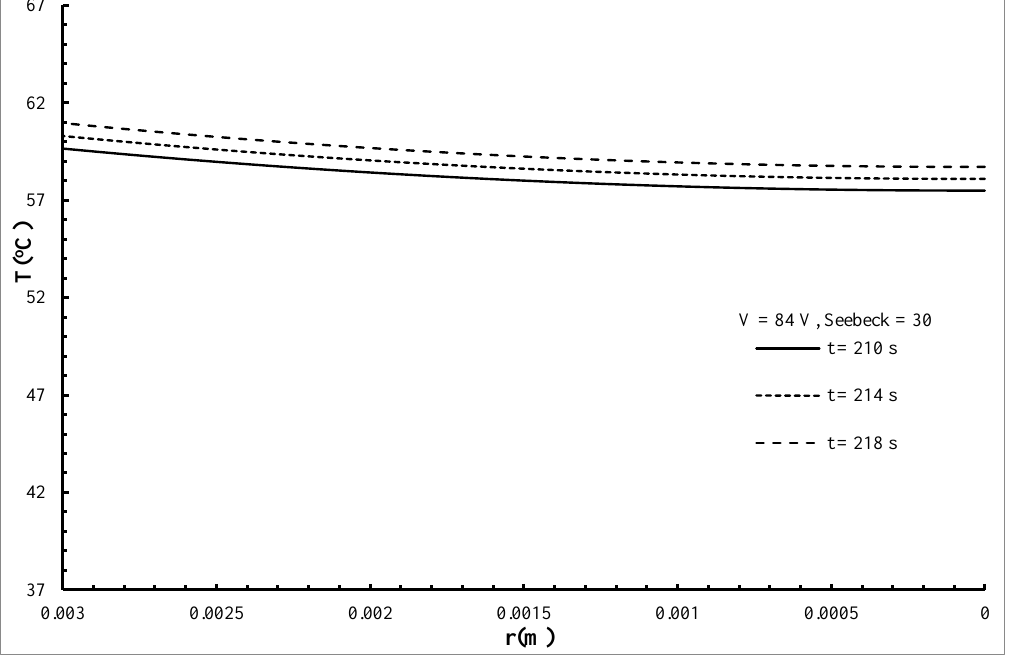
Figure 10 . The absolute temperature distribution of lipoma tumor with various values of time when Figure 10. The absolute temperature distribution of lipoma tumor with various values of time when 1300 R   . e R e = 1300 Ω